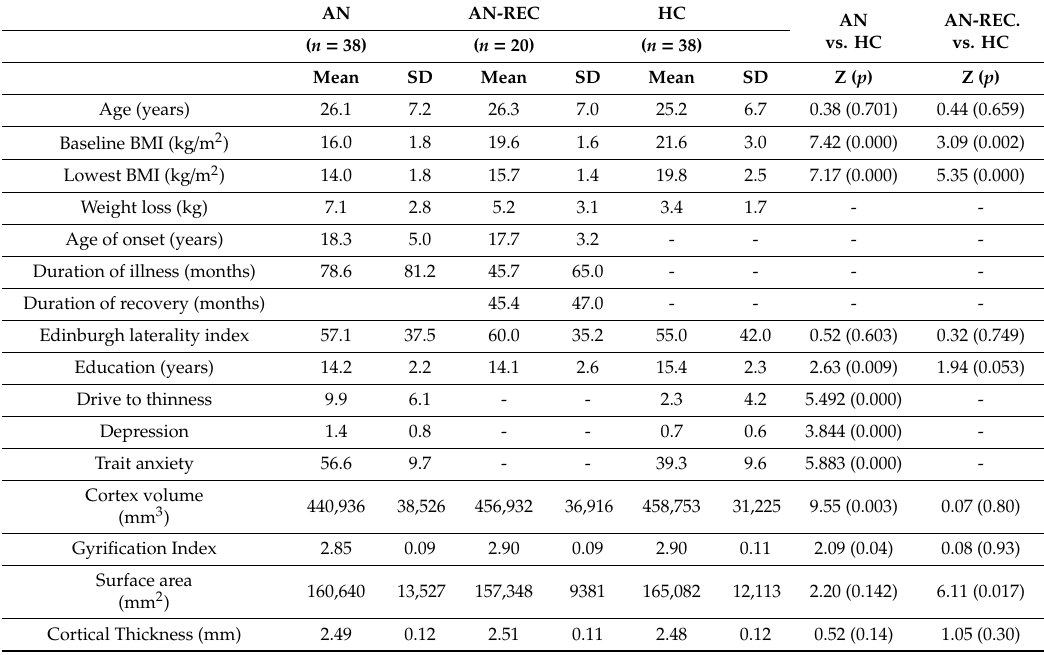
Table 1. Socio-demographic and clinical characteristics of the